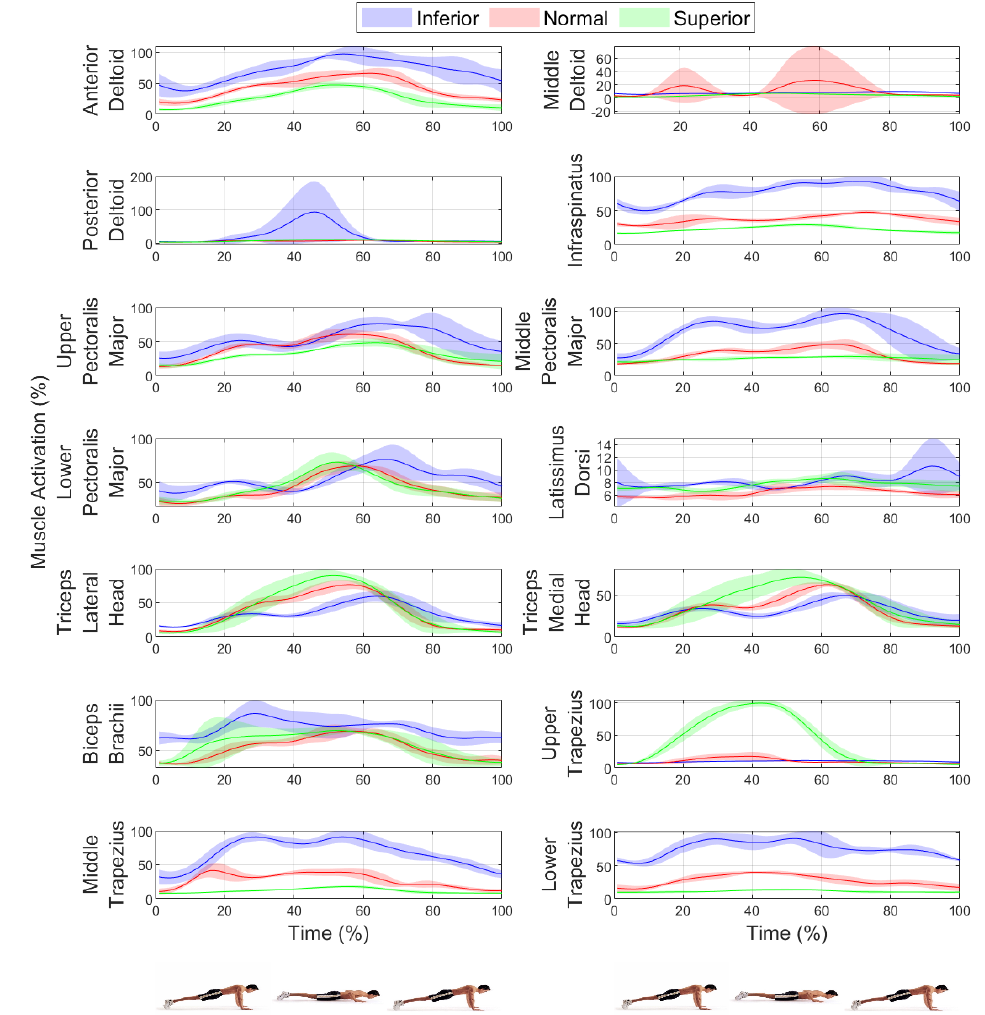
Figure 3. The mean and standard deviation of muscle activities for 14 muscles: the anterior deltoid, middle deltoid, posterior deltoid, infraspinatus, upper pectoralis major, middle pectoralis major, lower pectoralis major, latissimus dorsi, triceps lateral, triceps medial, biceps brachii, upper trapezius, middle trapezius, and lower trapezius muscles during the push-up exercise in three superior-inferior positions of palms (inferior, normal, and